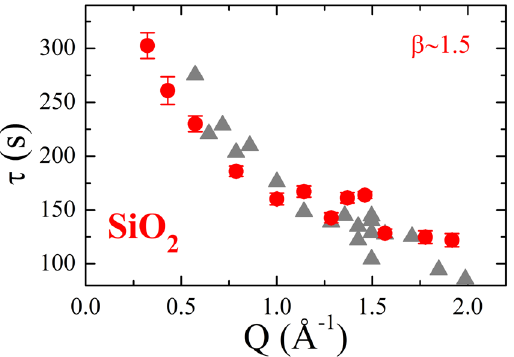
Figure 4. Wave-vector dependence of the X-ray induced dynamics. Wave-vector dependence of the characteristic decay time in vitreous silica measured at T = 295 K and for F 0 ≈ 1 · 10 11 ph/s (red circles). The grey triangles are taken with F 1 ≈ 3 · 10 10 ph/s and rescaled by the factor 2.74 corresponding to the X-ray intensity difference between the two